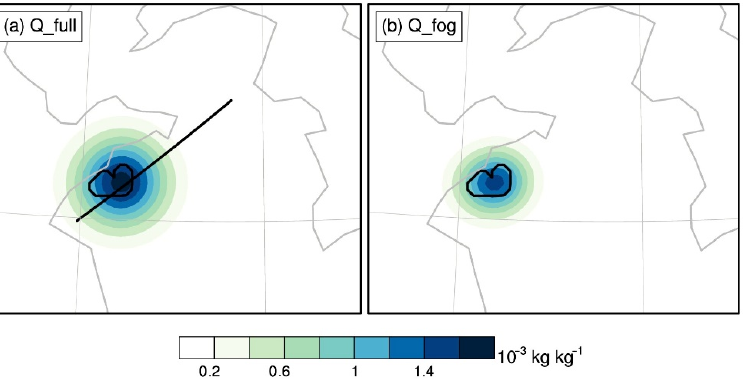
Figure 8. The analysis increments of water vapor mixing ratio (shaded; g kg − 1 ) from the satellite- derived humidity DA cycle valid at 1900 UTC 28 April 2007 for the first DA cycle of ( a ) Q_full and ( b ) Q_fog. The black contours outline the observed sea fog distributions.